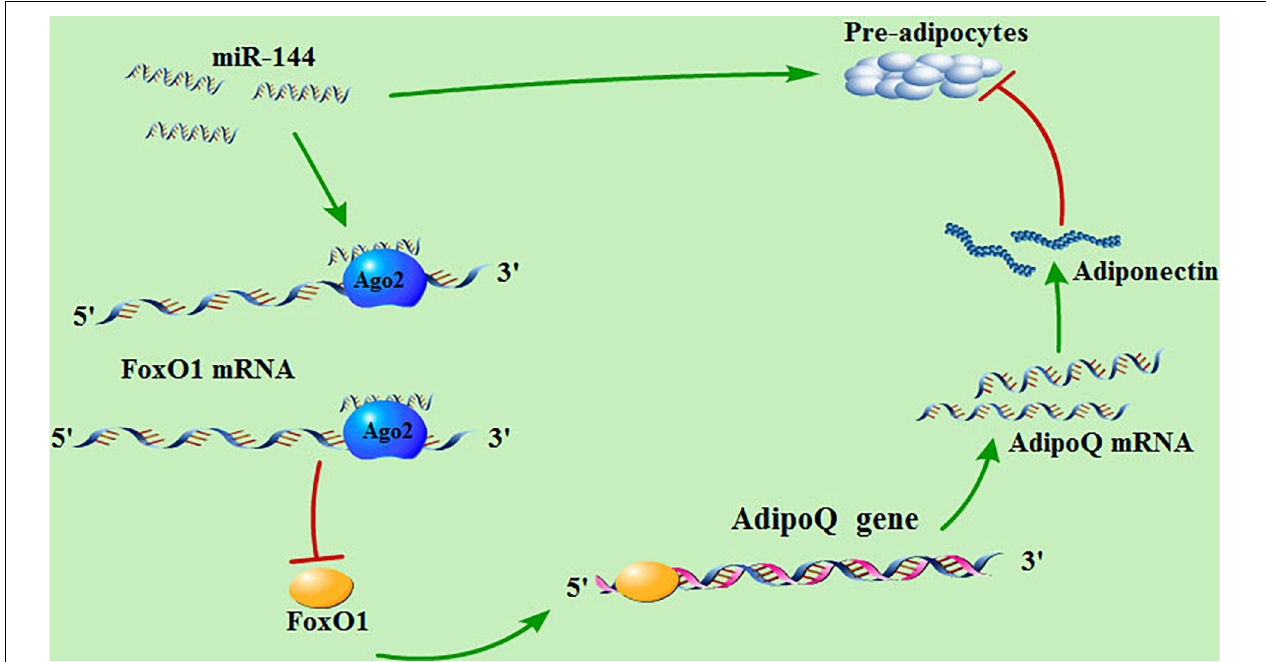
FIGURE 6 | MiR-144 regulates the signaling pathway of adipogenesis in pre-adipocytes. miR-144 targets FoxO1, thus reducing its expression and inhibiting its promotional effect on adiponectin, thereby alleviating the inhibitory effect of adiponectin on adipogenesis.